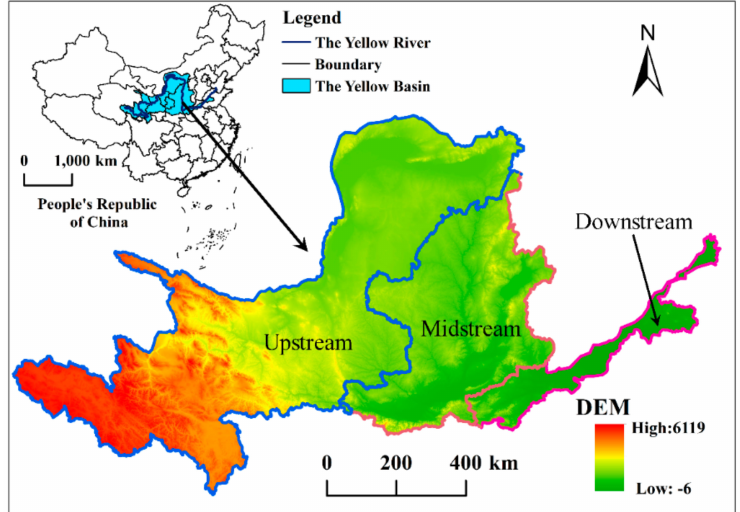
Figure 1. Location of the Yellow River